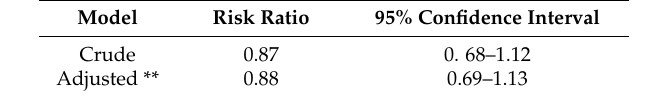
Table 2. Adjusted risk ratio for feeding mode and reflux among exclusively breast milk fed infants whose mothers participated in IFPS II in the U.S., 2005–2007